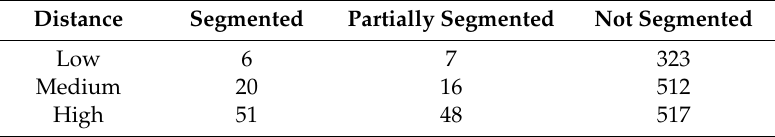
Table 6. Results of land segmentation using the Grabcut algorithm.